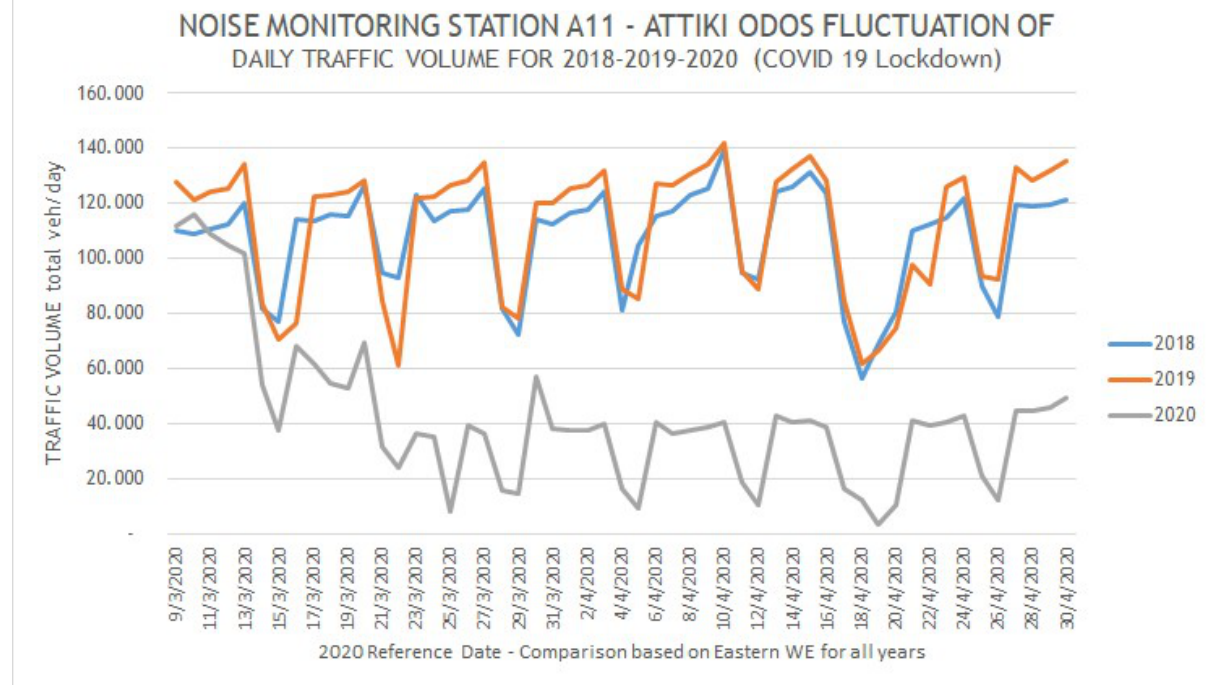
Figure 8e: Daily traflc volume – Noise monitoring station A11